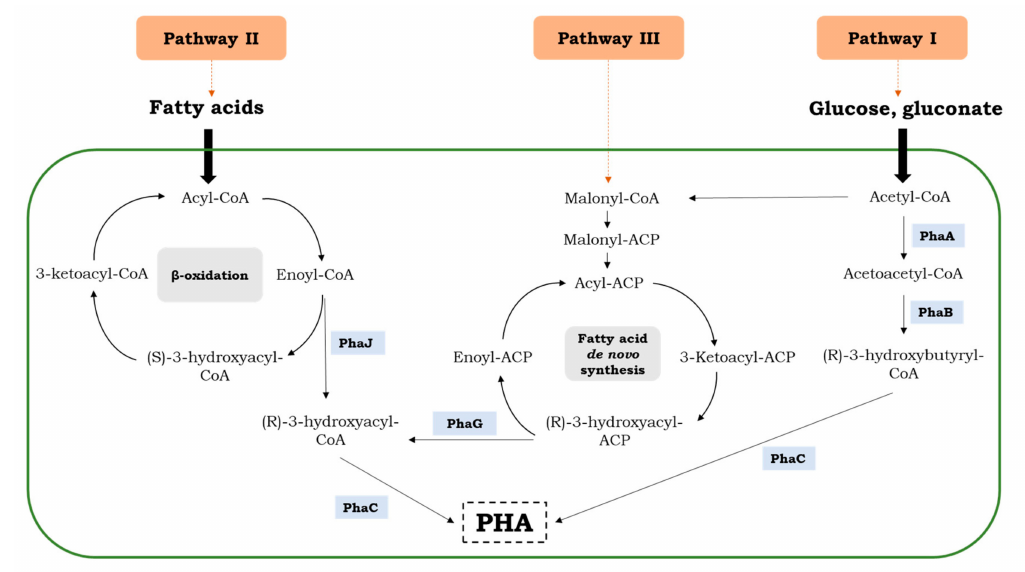
Figure 2. Metabolic pathways for synthesis of PHAs by the Aeromonas